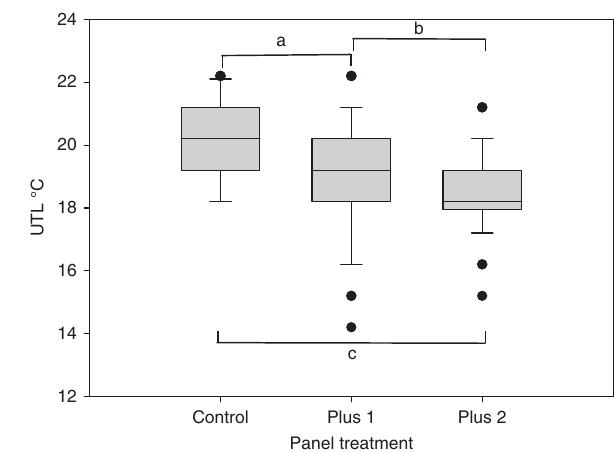
Fig. 2 Box plot showing acute UTLs for the spirobid polychaete R. perrieri . Central line of each box denotes the median, the top and bottom edges of the box show the 25% and 75% percentile, with the 10% and 90% percentiles shown by the upper and lower whiskers; outliers are shown as circles. Letters denote statistically signi fi cant differences between treatments (a: P = 0.0129; b: P = 0.000; c: P = 0.0200) (Mann – Whitney pairwise comparisons). Source data are provided as a Source Data fi le